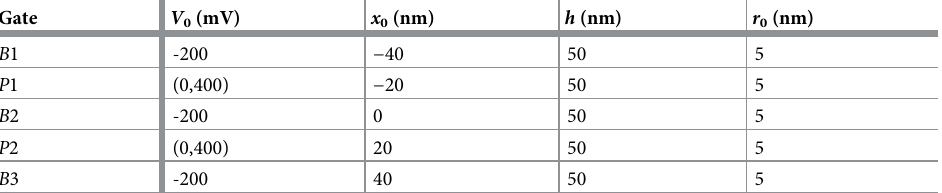
Table 1. Mean values for the parameters defining simulated 5-gates devices: Height of the potential profile ( V 0 ) at the gate position ( x 0 ), the height at which barriers were fixed ( h ), and the radius of the barrier gates ( r 0 ). The device size along x -axis is 120 nm, with the center positioned at x 0 = 0 nm. Gate V 0 (mV) x 0